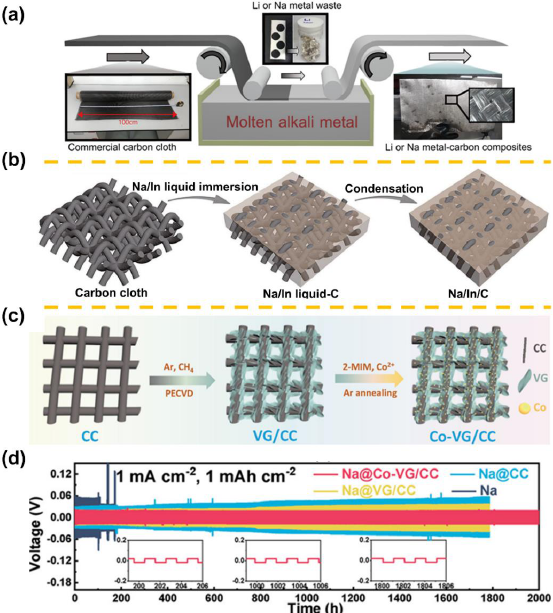
Figure 5. A schematic illustration of ( a ) the fabrication process for scalable Li or Na metal carbon composites production by utilizing a simple machine (adapted with permission from ACS), ( b ) the fabrication procedure of the Na/In/C composite (adapted with permission from Springer Nature), and ( c ) the synthetic process of the Co-VG/CC host. ( d ) Comparison of long-term cyclability of Na@CC, Na@VG/CC, and Na@Co-VG/CC at 1.0 mA cm − 2 with a fixed capacity of 1.0 mAh cm − 2 . The insets show enlarged profiles of specific cycles (adapted with permission from